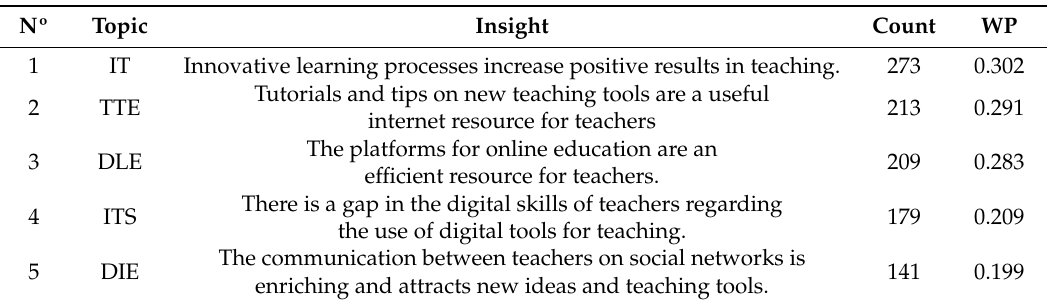
Table 3. LDA topics insight